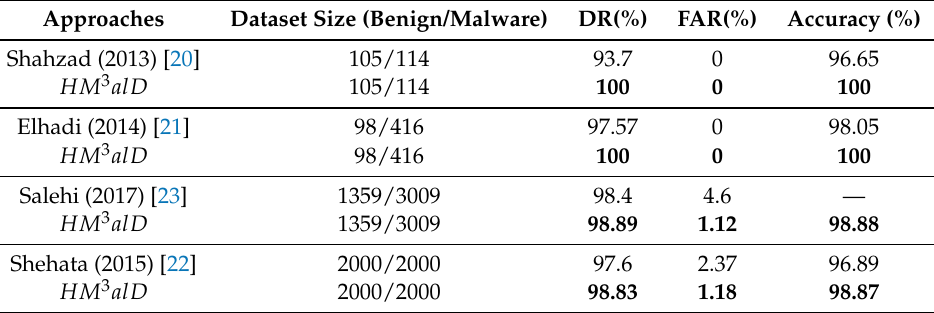
Table 4. Comparison of HM 3 alD with current dynamic malware detection methods.